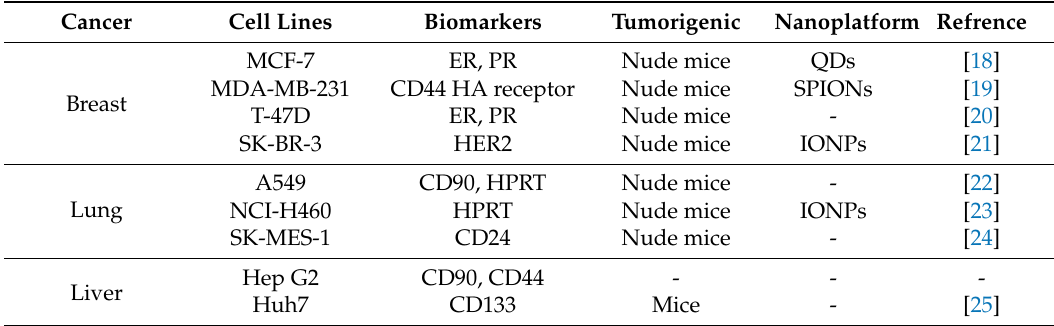
Liver ER, estrogen receptor; PR, progesterone receptor; HA, hyaluronan; HPRT, hypoxanthine-guanine phosphoribosyltransferase; IONPs, iron-oxide nanoparticles; SPIONs, superparamagnetic iron-oxide nanoparticles; QDs, quantum